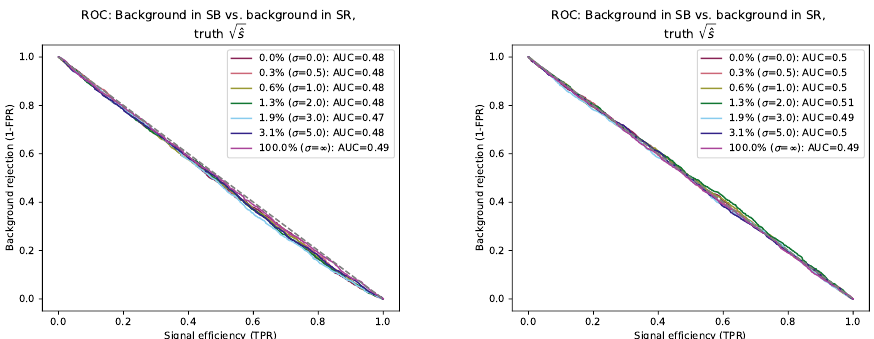
Figure 4. Receiver operating characteristic (ROC) curves from the weakly supervised training setup, comparing background in the sideband vs. background in the signal region, for the m 350 GeV signal region on the left and the m represents a different signal contamination in the training